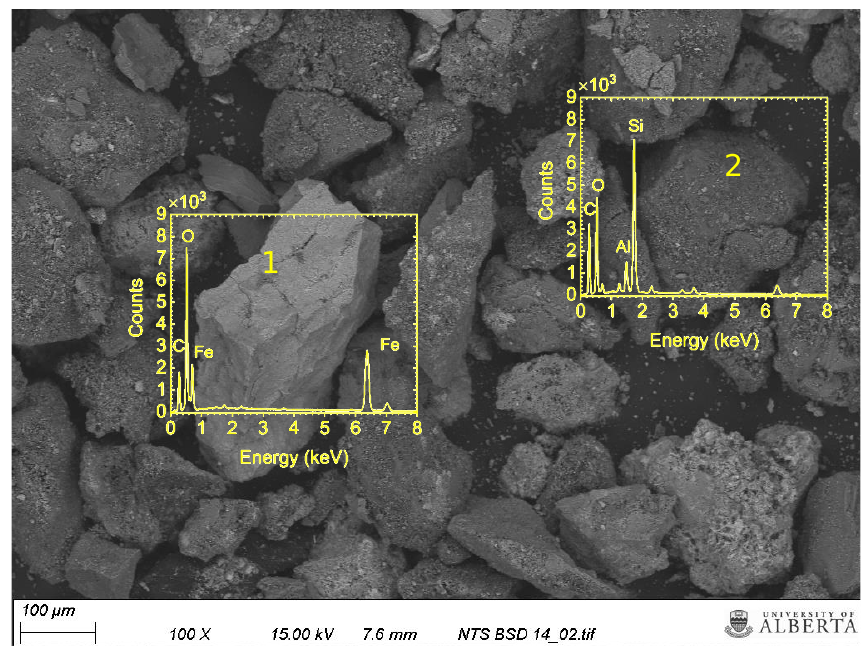
Figure 5. The EDS spectrum for two regions in the second scale sample. Region 1 has iron and oxygen peaks. This suggests the presence of iron oxide. Region 2 has aluminum, magnesium, and silicon peaks, suggesting the presence of silicate